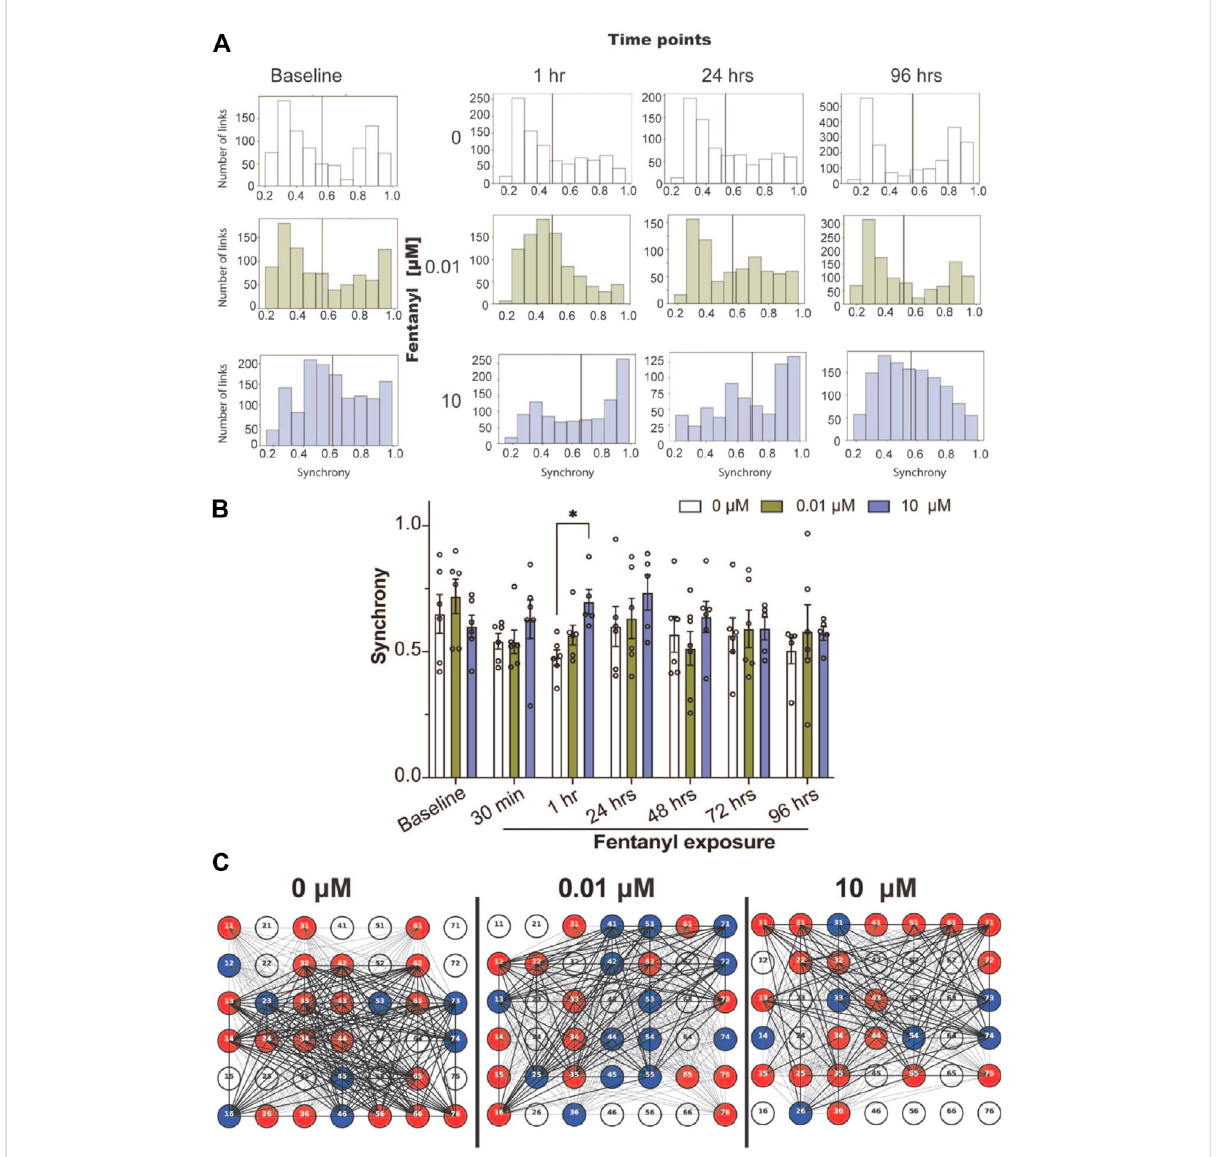
FIGURE 2 Synchrony and community analysis ofneural network activity before and during sub-chronic fentanyl exposure. (A) Histogram summarizes the distributionofthedegreesofsynchronized networks detected fromall networks(orlinks)pooled fromBOC devices intheuntreated- (e.g., 0 μ M) or fentanyl-treated(e.g.,0.01and10 μ M)conditions( n =5 – 7wells/treatmentcondition),shownatspeci fi ctime pointsoverthecourseof4 days.Black line indicates the mean synchrony value of all detected networks within the treatment condition. (B) Bar graph summarizes the average synchrony value from each well within the BOC device across the 7 time points. (C) Representative well on the BOC device for complex cultures at the 96 h time point that were untreated or treated with 0.01 or 10 μ M of fentanyl. Electrodes are numbered and are shown as inactive (white), or activeandpartofacommunity(color).Networkswithasynchronyvalue > 0.7isshownwithathickblacklineandvalues < 0.7areshownasathinblack line.Dataisshownasmean±SEMforthenumberofwellsineachtreatmentcondition( n =5 – 7wells)andwasanalyzedusingthemixed-modeltwo- way ANOVA with Tukey ’ s post hoc test. Statistical signi fi cance was observed between treatment condition at a level of * p <